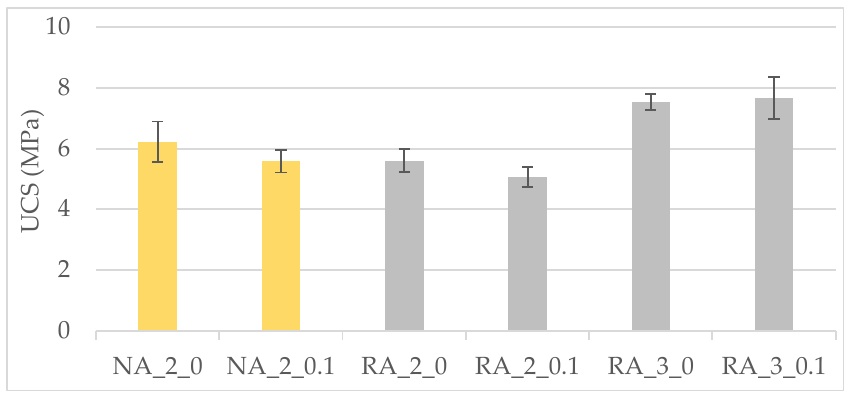
Figure 3. Unconfined compressive strength of the CBGM at 7 days of curing.